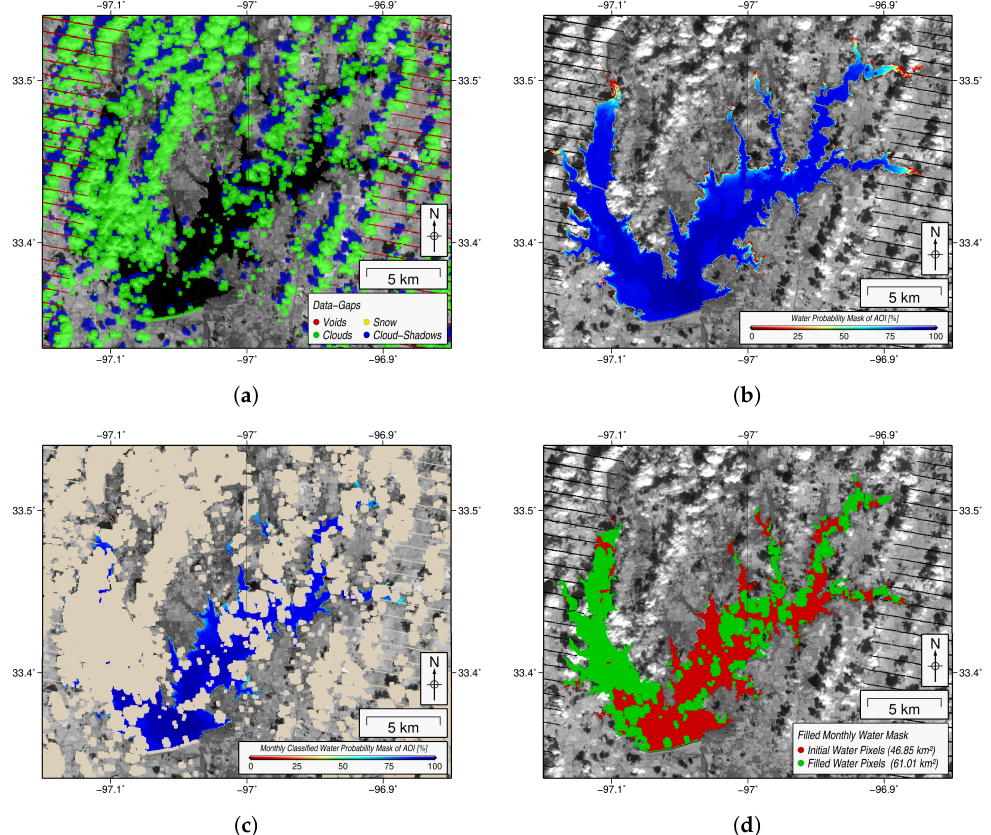
Figure 11. ( a ) Monthly mask with data gaps for Lake Ray Roberts in October 2012 ( b ) Long-term water probability mask ∩ AOI mask ( c ) Long-term water probability mask ∩ AOI mask ∩ water pixels of monthly mask ( d ) Filled monthly land-water mask with A initial (red) and A fill